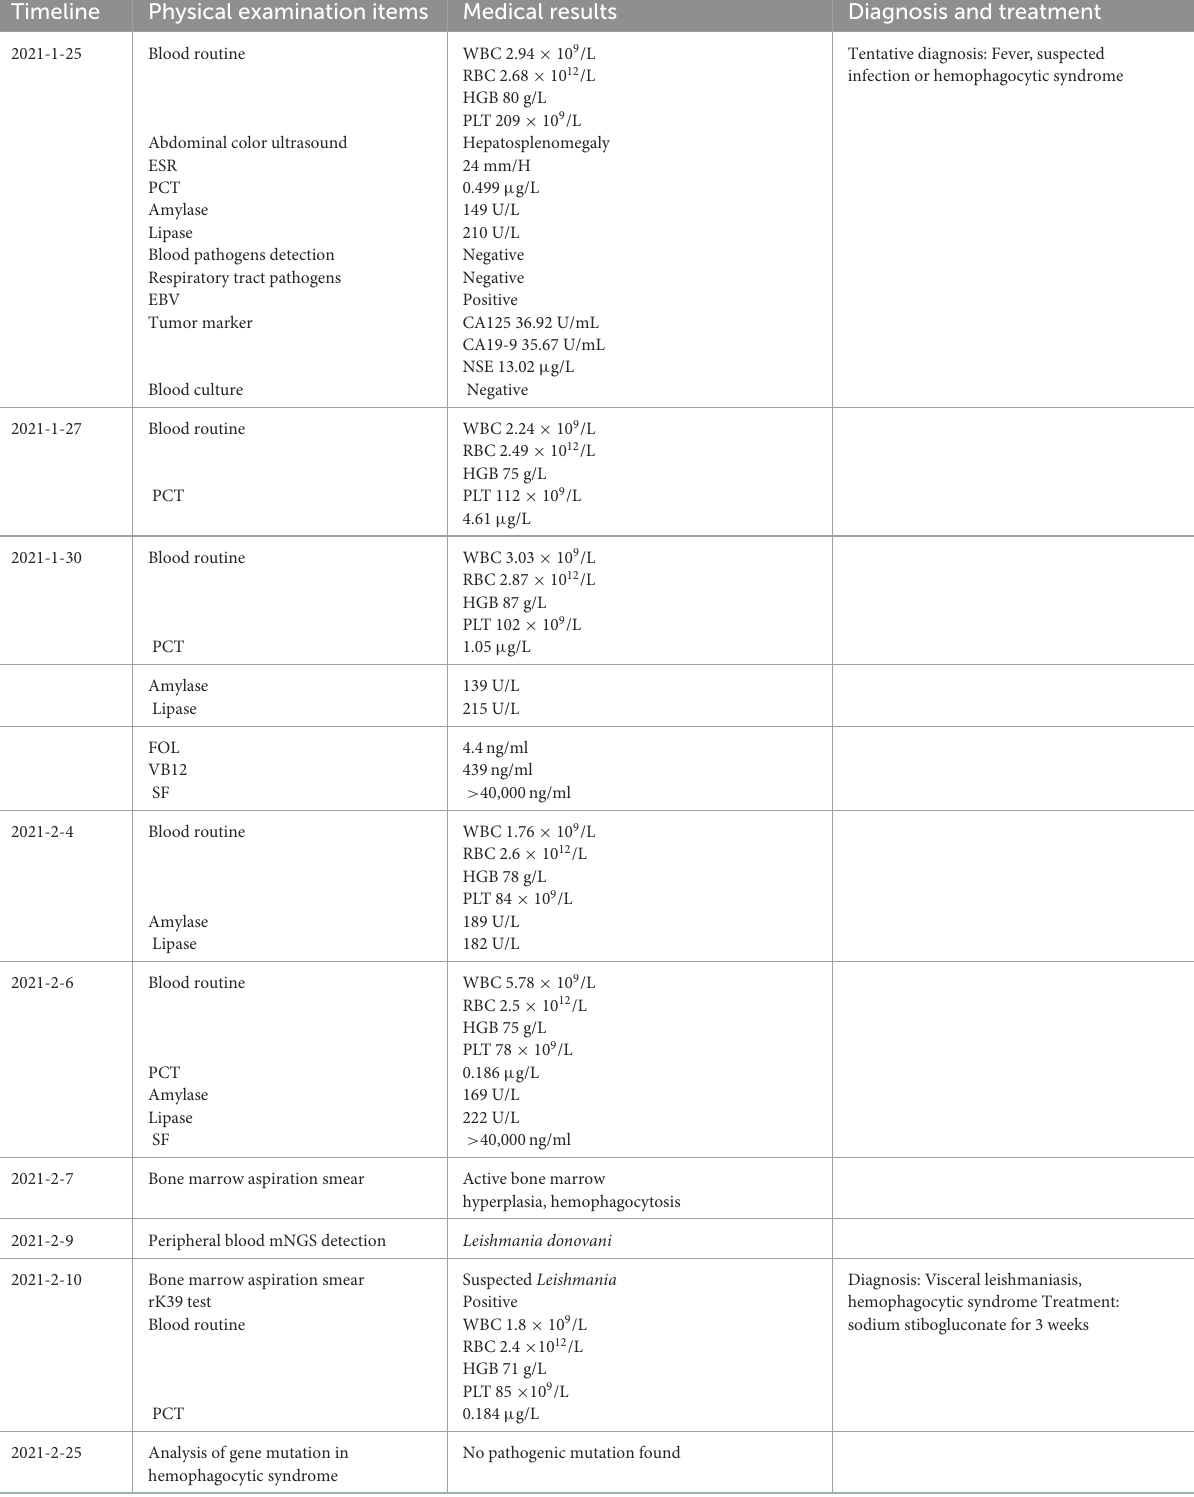
TABLE 4 Timeline of diagnosis and treatment in the case